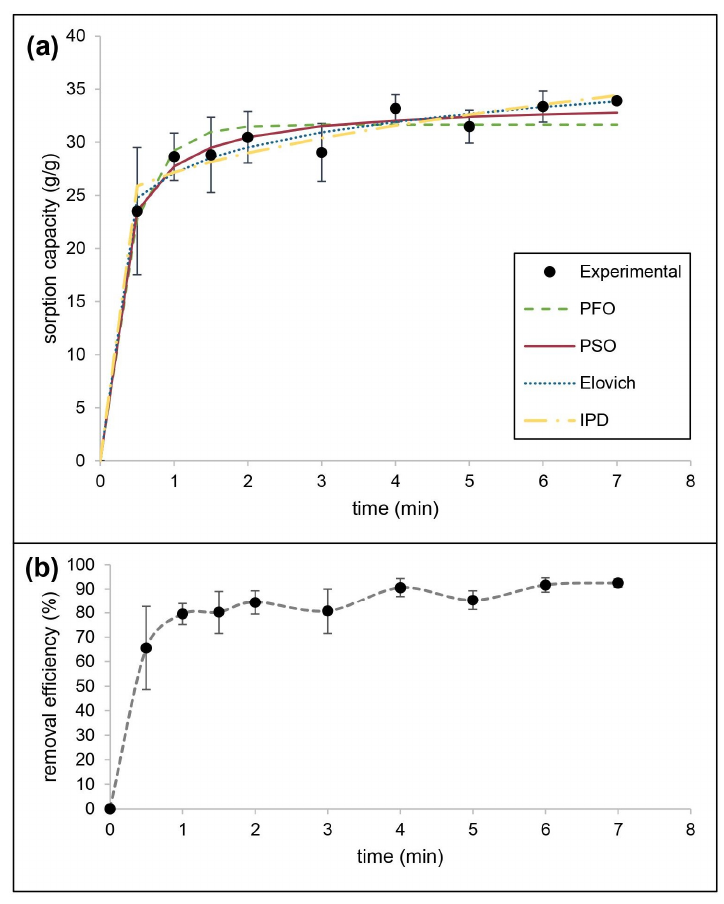
Figure 9. (Color online) ( a ) Kinetic modeling of experimental data and ( b ) removal efficiency for motor oil sorption by CaSt 2 -KF.